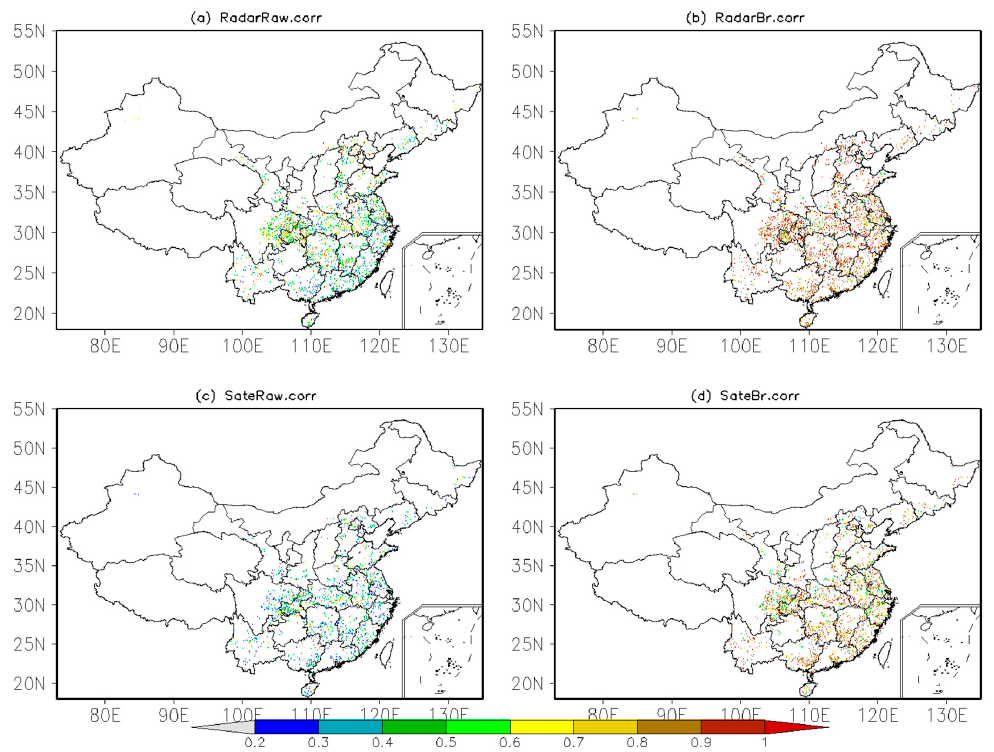
Figure 13. The same as Figure 11, but for correlation coefficient.